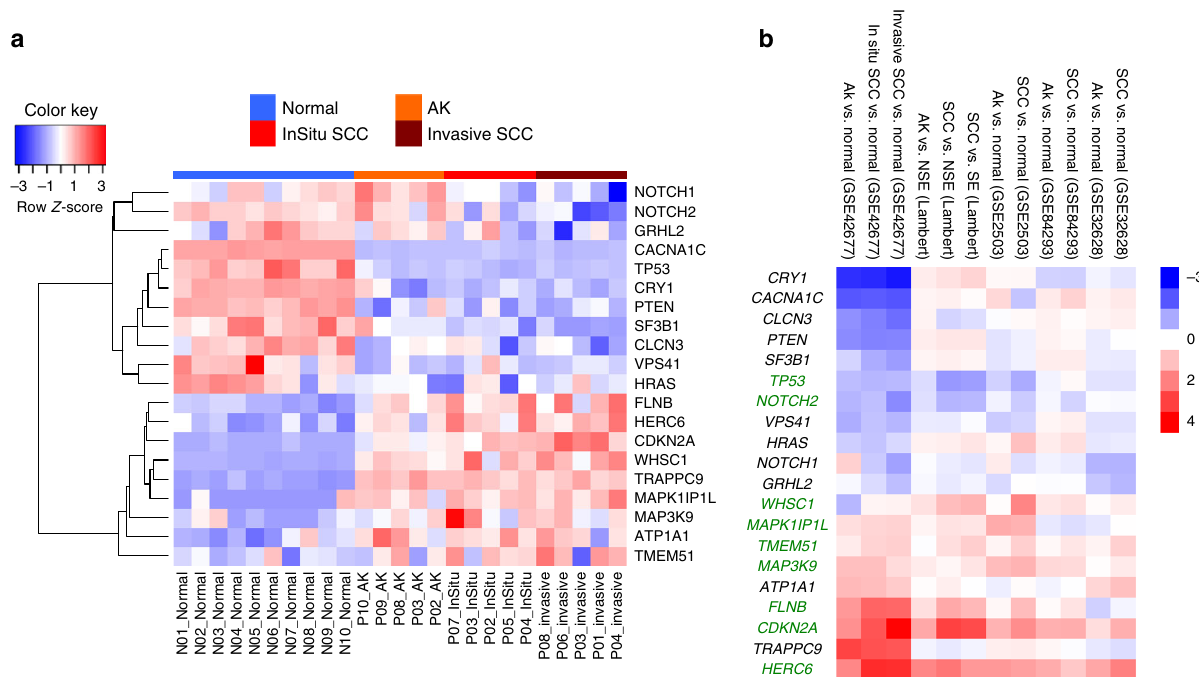
Fig. 5 Expression pro fi les of driver genes in fi ve independent gene expression data sets. a Expression heatmap of 20 SMGs that were also expressed across normal, AK, in situ and invasive SCC samples from GSE42677. b Log 2 fold changes (FC) of AK vs. normal and SCC vs. normal of 20 SMGs from GSE42677, Data set 1 (Lambert), GSE2503, GSE84293 and GSE32628. Normal normal skin, NSE non-sun exposed normal skin, SE Sun exposed skin, AK actinic keratosis. Signi fi cant genes in 3 out of 5 data sets were highlighted in green. Within the heatmap, red colour indicates the upregulation in AK or SCC compared to normal control, which blue colour indicates the downregulation in AK or SCC in relation to normal